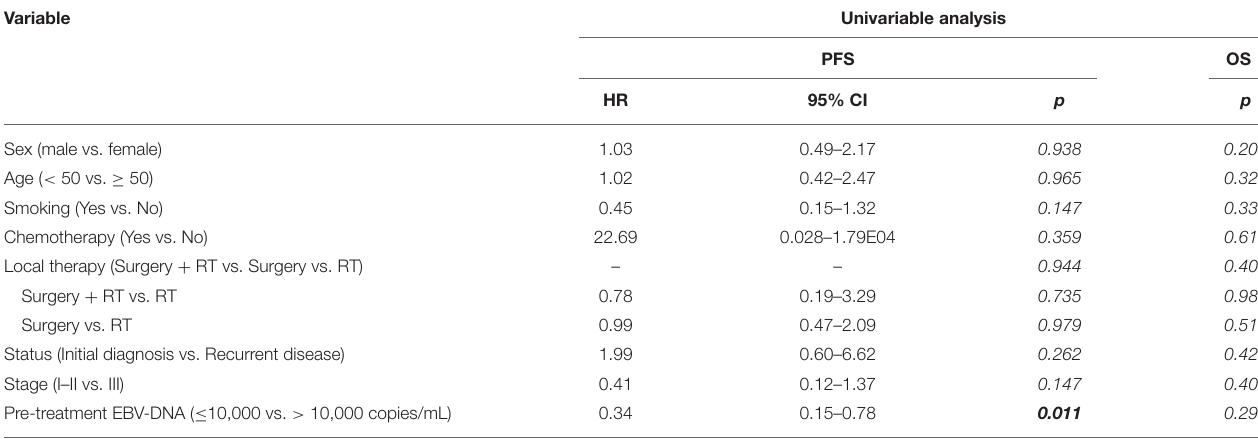
TABLE 2 | Univariable Cox regression analysis in the pre-treatment set. Variable